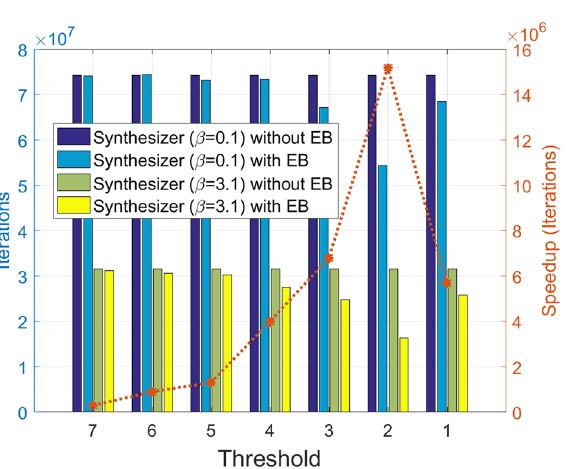
Figure 5. Two modes in stochastic synthesis. In the normal mode, a gate is randomly replaced with another gate. Without knowing the erroneous gates, the new proposed program usually leads to rejection. This may end up using thousands of iterations exploring the wrong regions. However, in the acceleration mode where it is important to locally refine a program without globally dramatically modifying the structure of the program, we calculate the error and backpropagate it to find the erroneous gates. We replace a gate in this set with another to increase the probability of searching for a better program. For example, in this Fig., instead of choosing an irrelevant gate 4, we replace gate 5 and the proposed program is accepted.